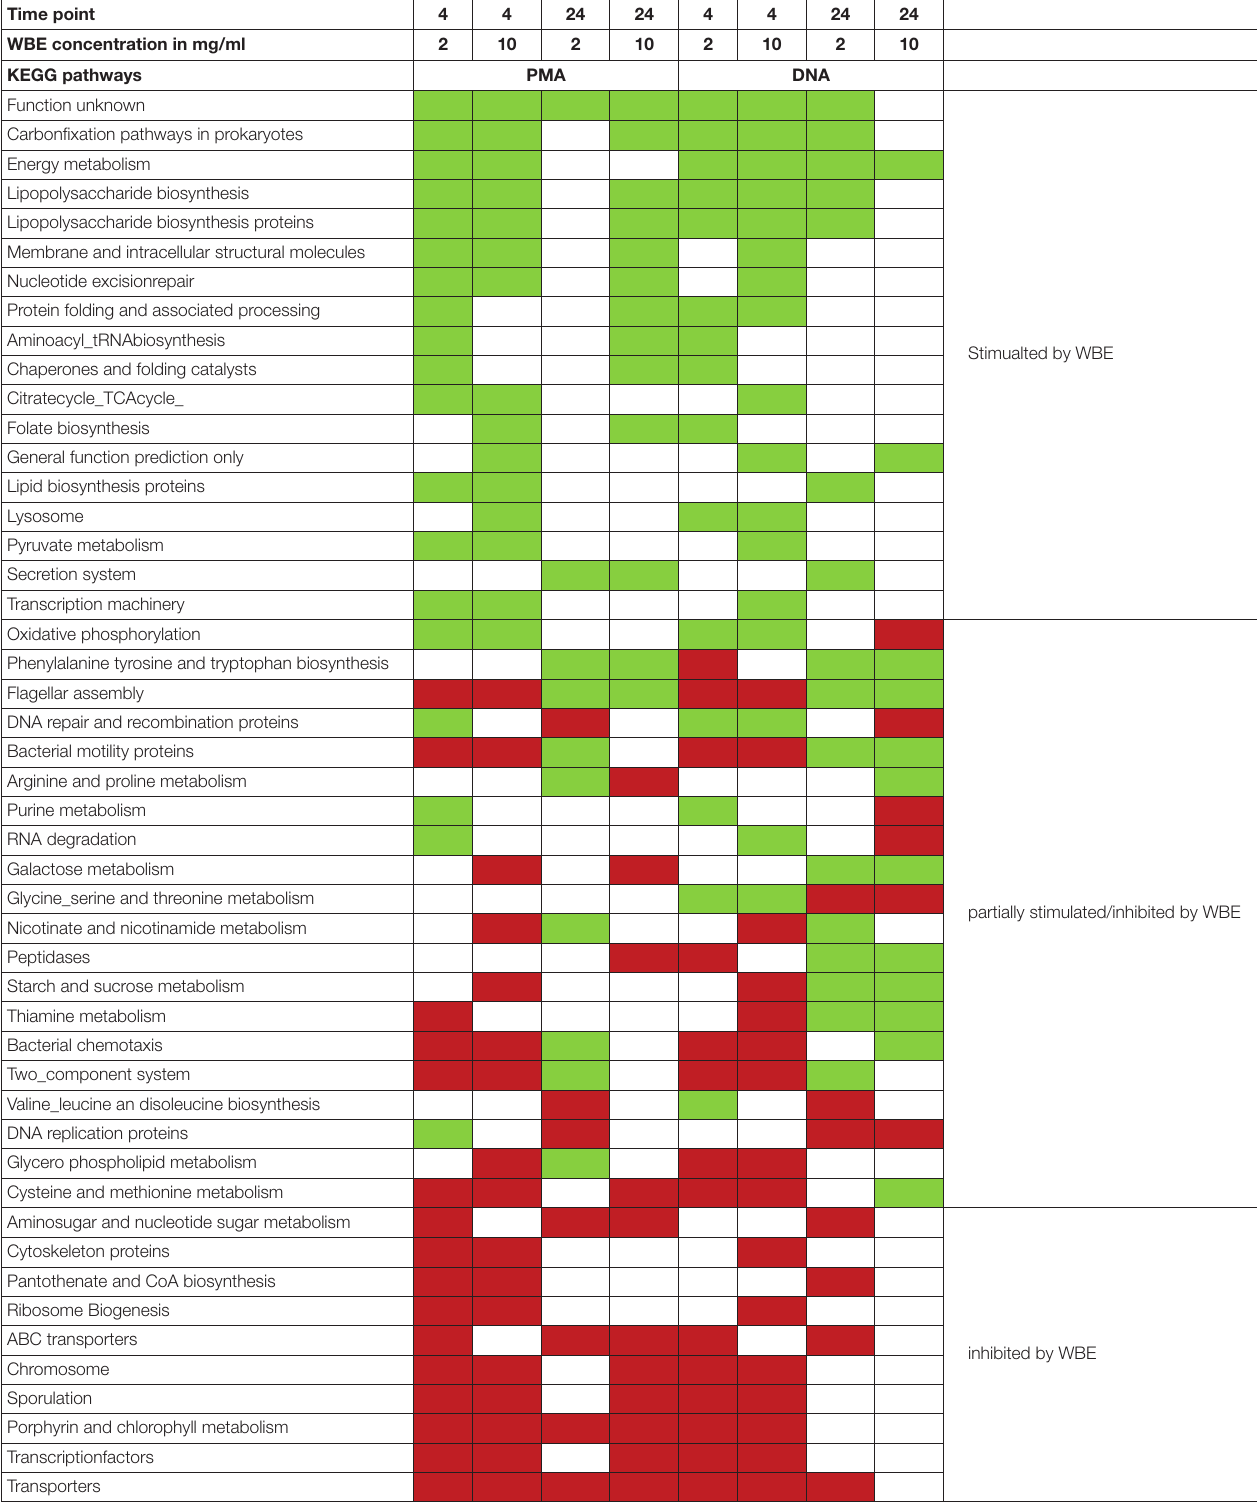
TABLE 2 | Significantly increased and decreased microbial